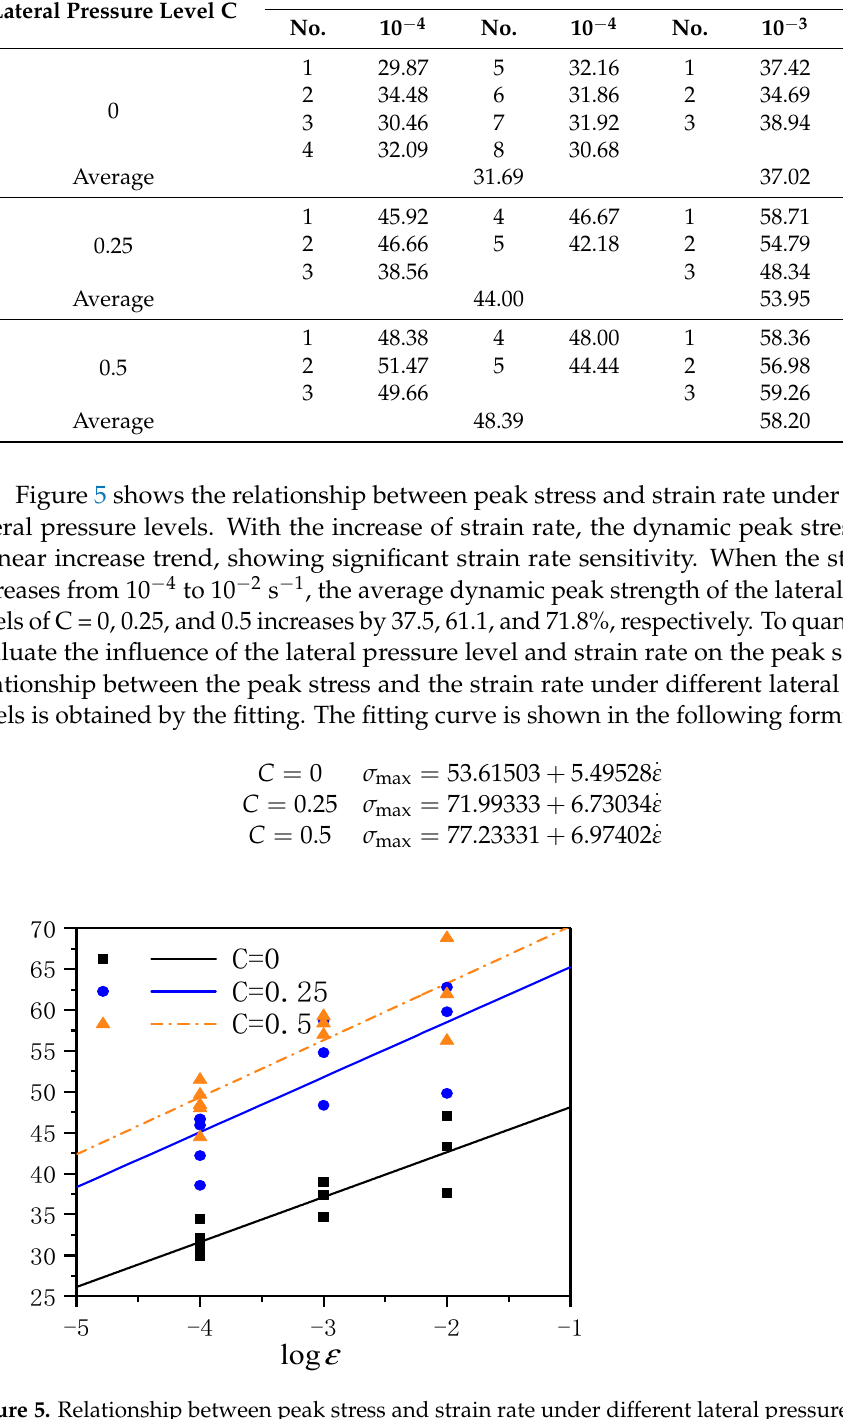
Figure 5. Relationship between peak stress and strain rate under different lateral pressure levels. In Equation (3), σ max is the peak stress under the dynamic strain rate, is the dy- namic strain rate. The correlation coefficient R 2 is 0.999, 0.858, 0.895, respectively. The correlation coefficient R 2 is relatively high, so it can be considered that the fitting curve can describe the relationship between the average compressive strength under different lateral pressures. The fitting curve can be found through that as the lateral pressure level increases, the intercept of the fitting curve increases, but the rate of increase decreases; as the lateral pressure level increases, the slope of the fitting curve gradually increases. When the strain rate keeps constant, with the lateral pressure growing, ECC’s average peak stress also keeps growing. 3.2.3. Dynamic intensity growth factor DIF − σ For evaluating the strain rate sensitivity of a material’s strength, the dynamic strength growth factor DIF − σ value is generally used for research [21]. The calculation method of DIF − σ is: σ σ σ− = (4) Among them, σ 1 represents the dynamic compressive strength under different lat- eral pressures and strain rates, and σ 0 represents the static compressive strength of dif- ferent lateral pressure levels (C = 0, 0.25, 0.5). In such conditions, the uniaxial crushing strength under the shape of a strain rate of 10 − 4 s − 1 has functioned as the benchmark static crushing strength, and the calculated results are shown in Table 6. Table 6. Dynamic intensity growth factor (DIF) − σ values of ECC under different lateral pressure levels. Lateral Pressure Level C Strain Rate (s − 1 )